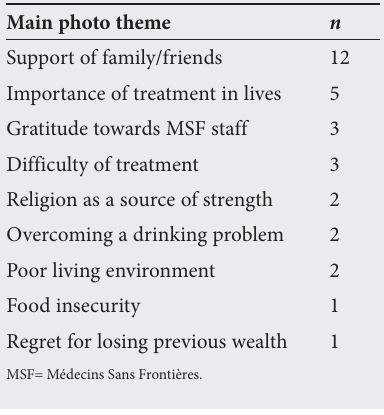
Table 2. Frequency of themes of photographs shared on